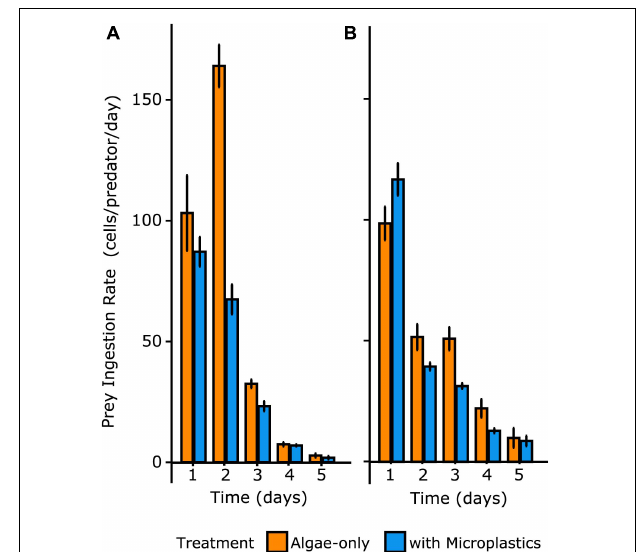
FIGURE 4 | Ingestion rates of algal prey through time over 5 days for O. marina (A) and Gyrodinium sp. (B) Irrespective of treatment, ingestion rate decreased over time with decreasing prey particle concentration. Error bars indicate one standard deviation of the